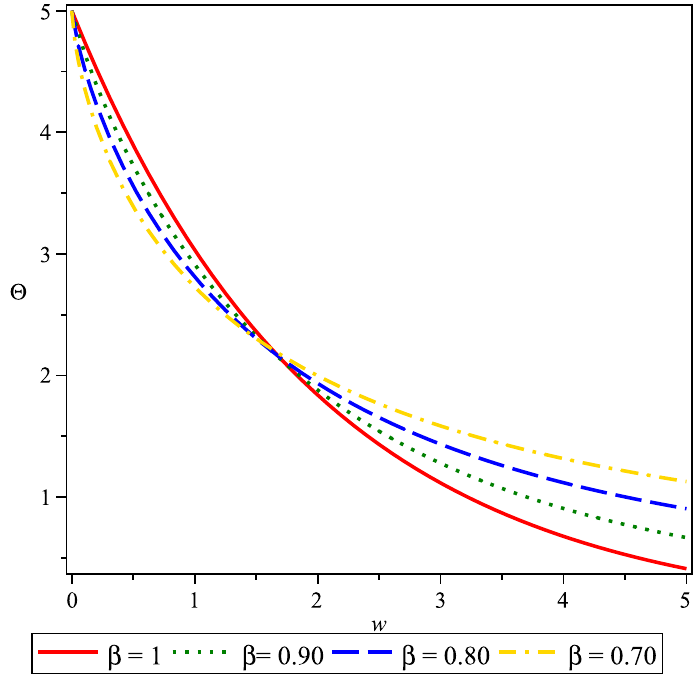
Figure 1. Plots of solution Θ for the fractional kinetic equation (FKE) (25) when Θ 0 = 5, ℘ = 0, and c =